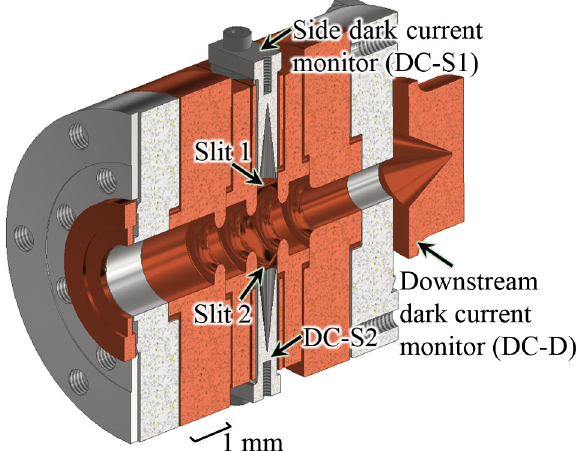
FIG. 9. The half section view of the assembly diagram of the E structure. The two slits are shown in parallel with the cross section. The side dark current monitors receive the current on the immediate outside of the slits.